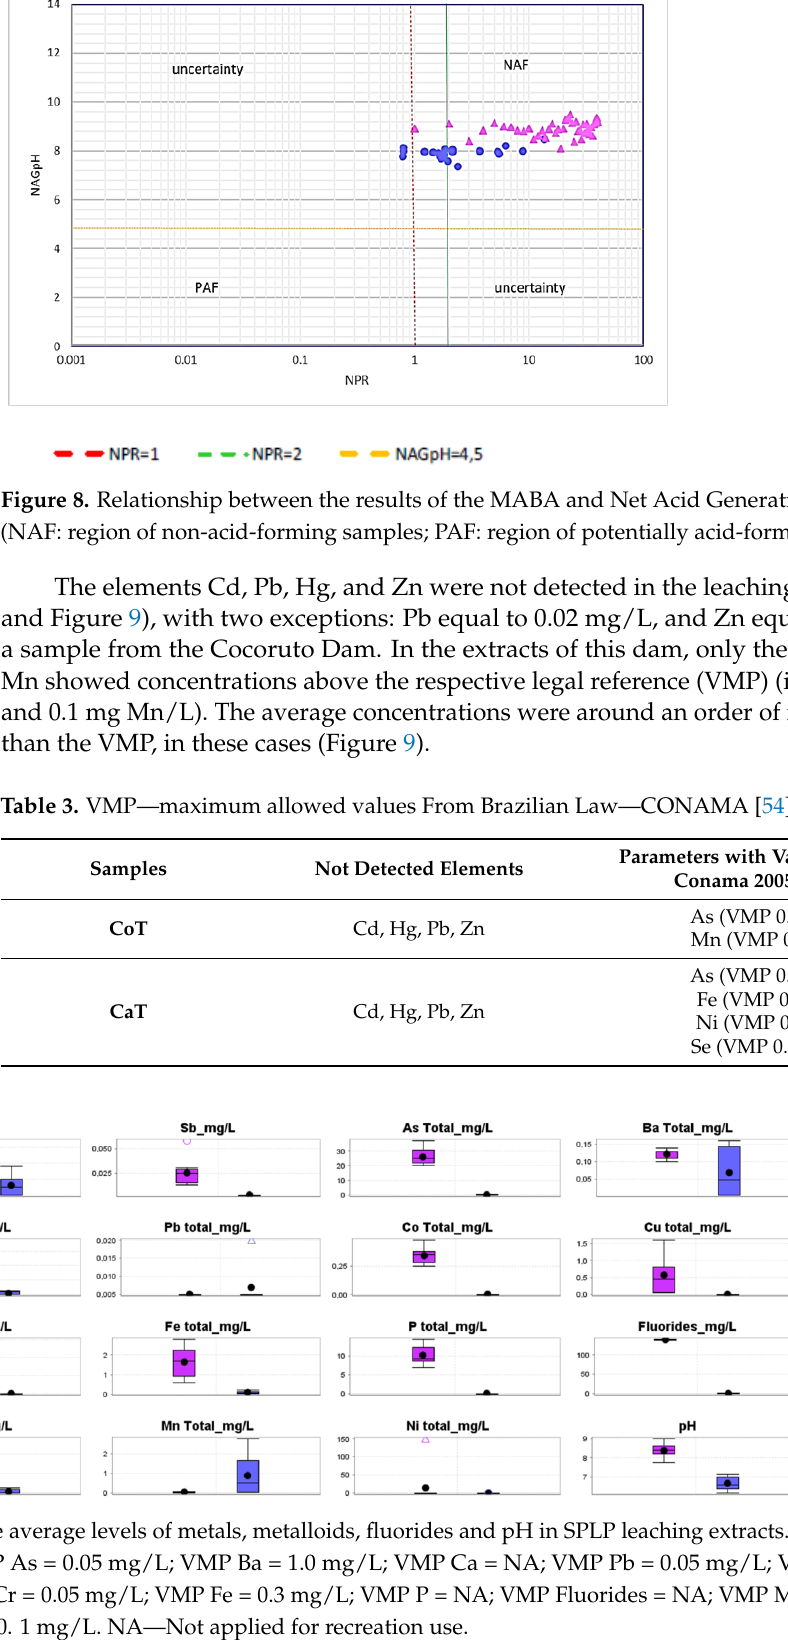
11 of 16 Figure 7. Results of Modified Acid-Base Accounting (MABA) tests ( a ) global and ( b ) for CoT, by sampling depth. The NAG test (net acid generation) was another method used in order to compare with the results obtained by MABA, mainly because of the S grades. Figure 8 presents the graph NAGpH versus NPR, allowing to correlate the results of the MABA and NAG-tests, and to better refine the classification of acid generation potential of the samples under analysis. The results of the NAG test showed a pH value well above the limit of 4.5, indi-